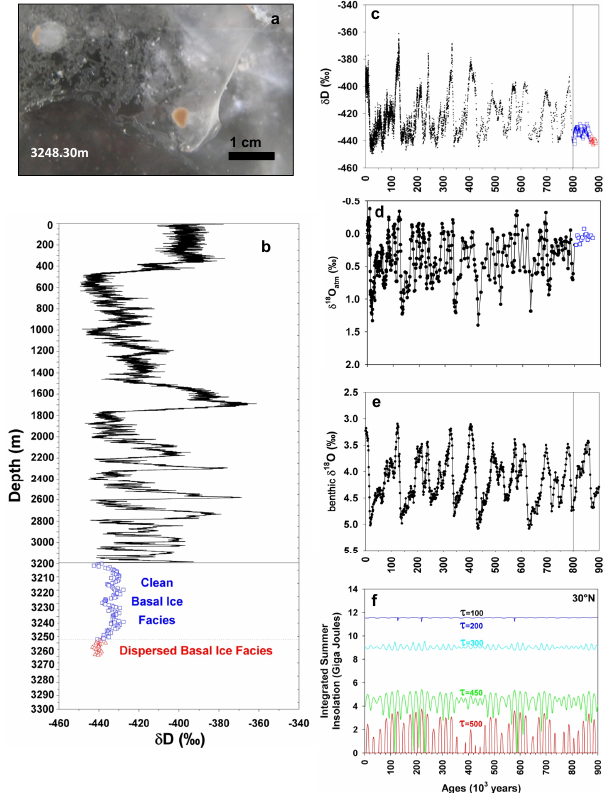
Figure 1. (a) visual appearance of the EDC basal ice in the lower metres of the core (photo: D. Dahl-Jensen), (b) EDC δ D ice vs. depth, (c) EDC δ D ice vs. age (EDC3 timescale extended to the basal ice layers), (d) combined Vostok and EDC δ 18 O atm vs. age (adapted from Dreyfus et al., 2007), (e) δ 18 O vs. age for the benthic record stack of Lisiecki and Raymo (2005), and (f) integrated summer in- solation for various thresholds ( τ ) at 30 ◦ N vs. age, as calculated by Huybers (2006). For reasons described in the text, ice below 3189.45m depth is referred to as “clean ice facies” (blue squares) and “dispersed ice facies” (red triangles) describes the ice below 3248.30m, where solid inclusions are